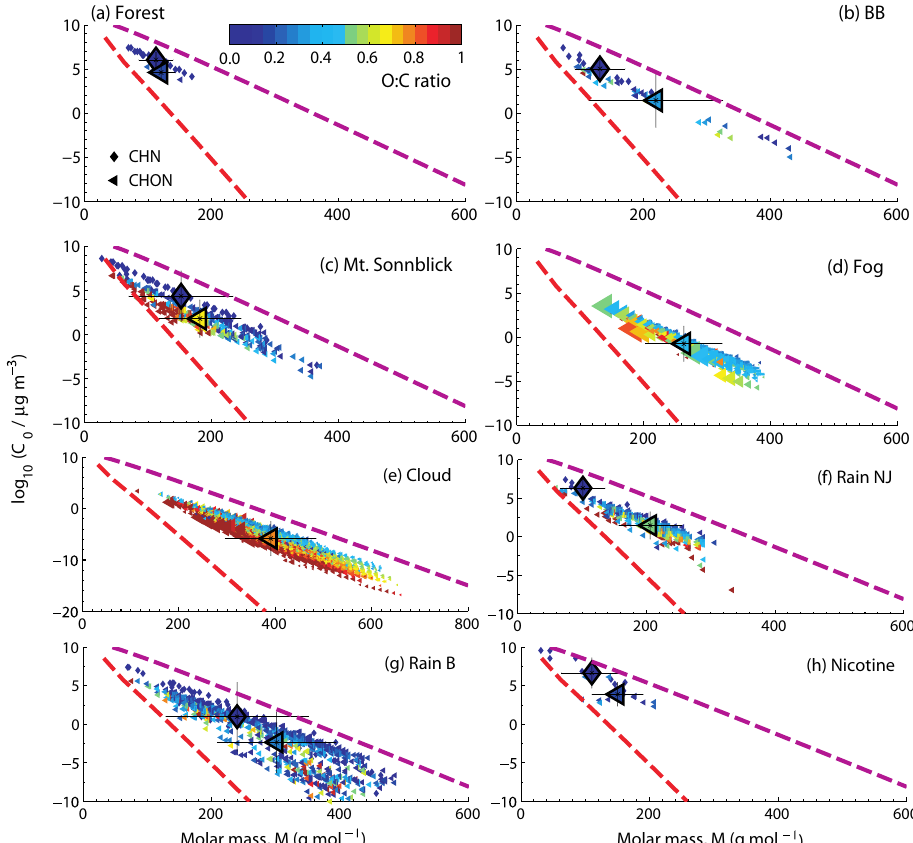
Figure 6. Molecular corridors of saturation mass concentration ( C 0 ) vs. molar mass ( M) for N-containing compounds collected from (a) boreal forest (Ehn et al., 2010, 2012), (b) biomass burning (Laskin et al., 2009), (c) high alpine air at Mt. Sonnblick (Holzinger et al., 2010), (d) fog in Fresno (Mazzoleni et al., 2010), (e) cloud at Mt. Werner (Zhao et al., 2013), (f) rain in New Jersey (Altieri et al., 2009a, b), (g) rain in Bermuda (Altieri et al., 2012), and (h) tobacco smoke (Sleiman et al., 2010a, b). The small markers represent individual compounds color-coded by atomic O : C ratio. The size of the small markers in (d) and (e) is linearly scaled by relative intensity of MS signal. The larger symbols with error bars indicate the surrogate compounds with the mean values of M , C 0 , and O : C ratio (relative abundance considered for d and e